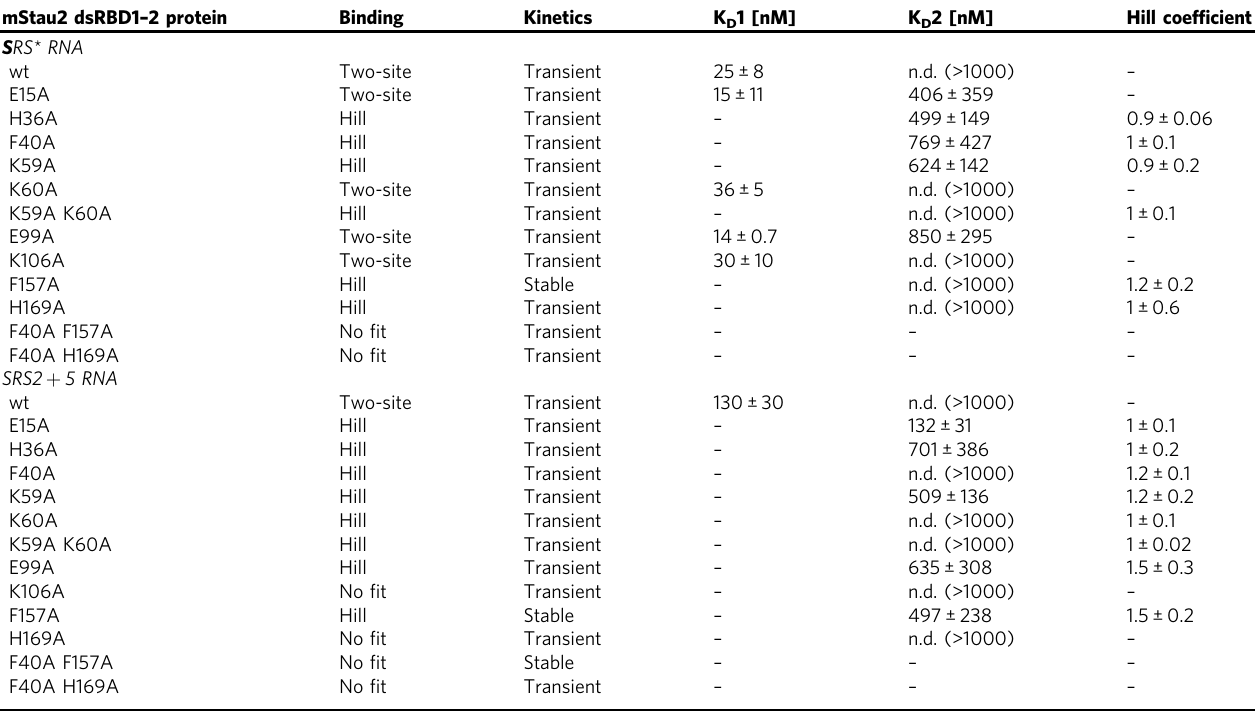
Table 3 mStau2 dsRBD1 – 2 mutant binding to SRS* and SRS2 + 5 RNA mStau2 dsRBD1 – 2 protein